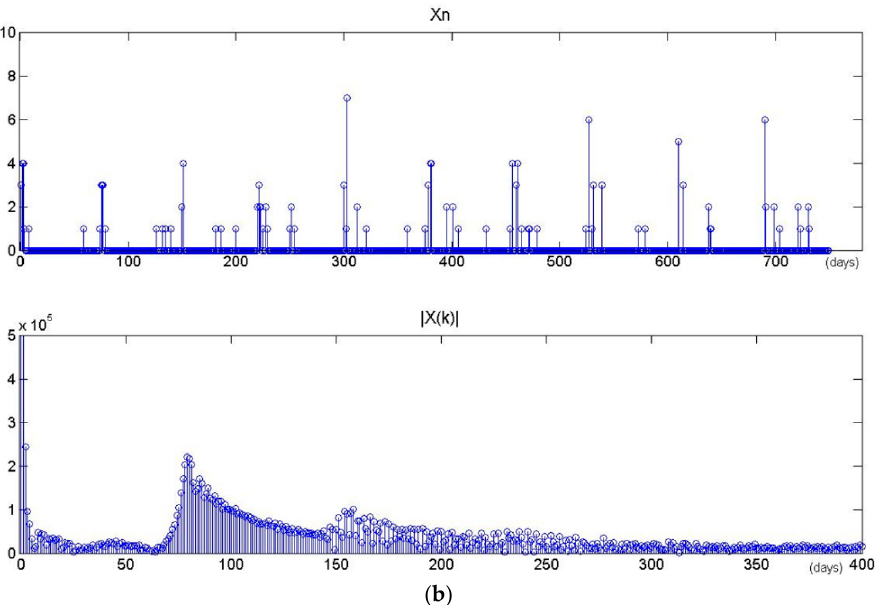
Figure 12. Time series and their DFTs with different values of M . ( a ) M = 20. ( b ) M = 40.